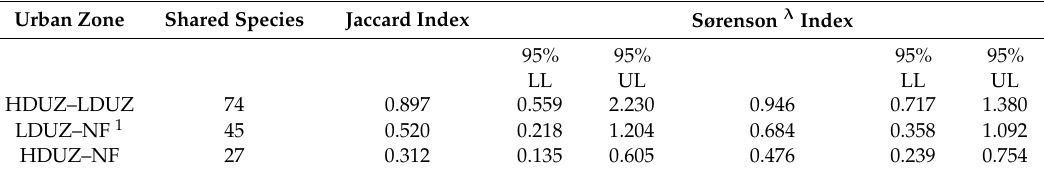
Table 4. Similarity (Jaccard and Sørenson indices) in species composition among urban zones in Kumasi. Values close to one indicate high similarity and close to zero indicate high dissimilarity. Bootstrap 95% confidence intervals are also shown.